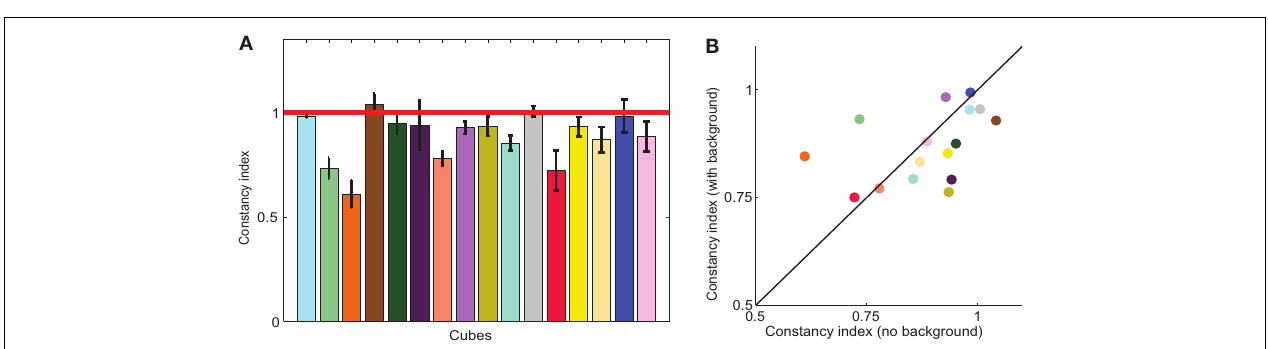
the number of observers who chose that chip. Filled data points represent average color matches, and black solid crosses show constancy predictions. The x- and y-axis ranges are consistent between plots, though the starting point shifts to accommodate the relevant chromaticity range.